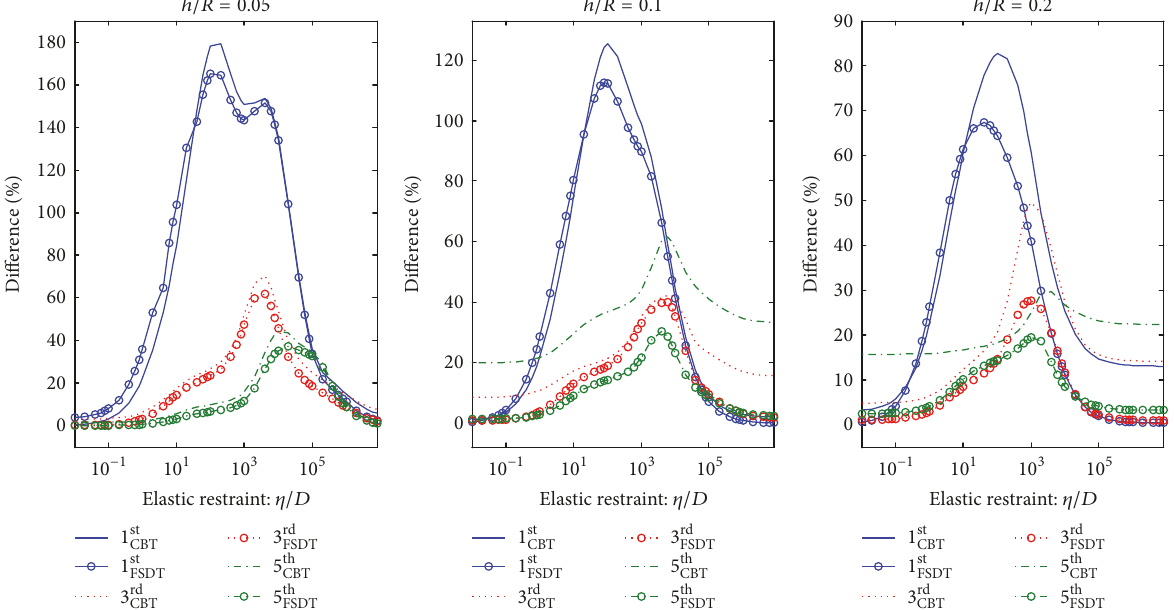
Figure 10: Relative deviations between frequency parameters Ω based on the CBT/FSDT theory models to those of 2D theory for elastically restrained circular beams with different restraint rigidities ( 𝜃 = 𝜃 0 : clamped; 𝜃 = 𝜃 1 : 𝑘𝑢 = 𝑘𝑤 = 𝜂 ).